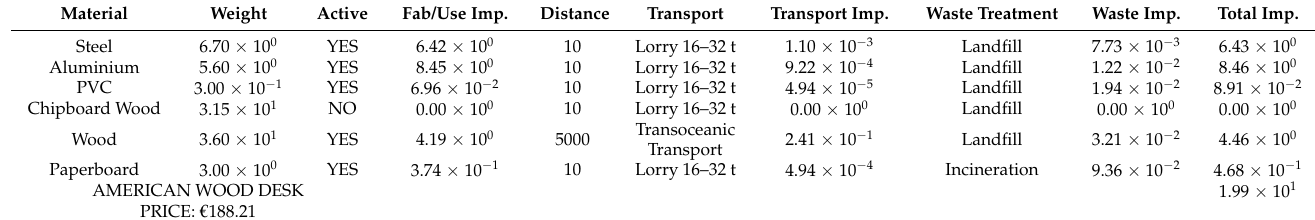
Table 9. Results of American wood desk scenario.